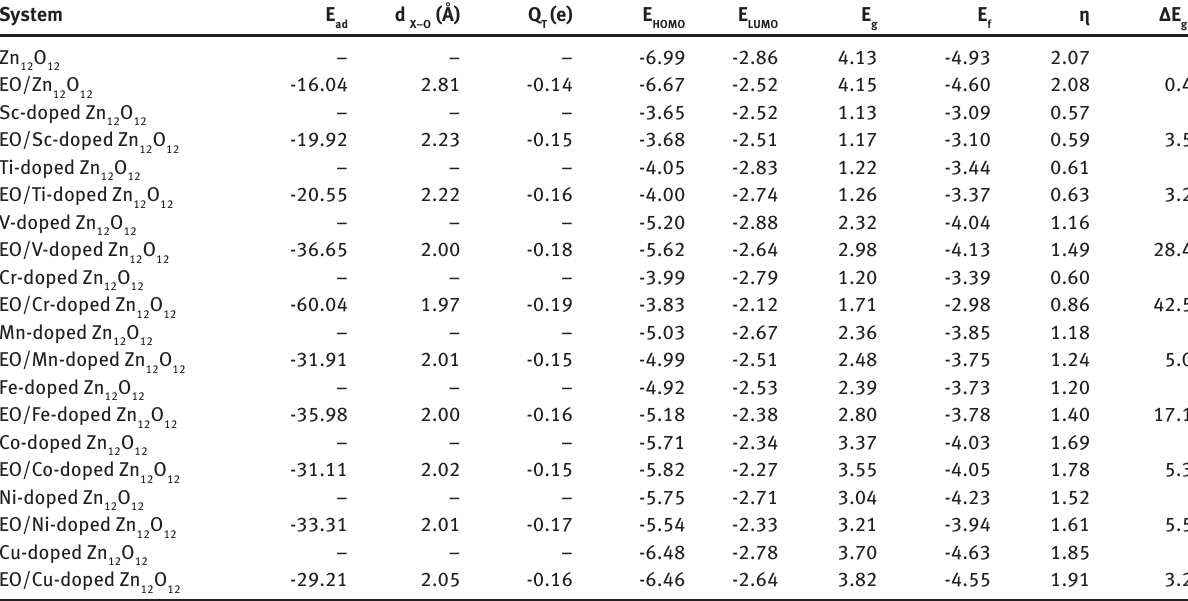
(kcal/mol), HOMO, LUMO, E and E (eV) for the studied systems. The average total Mulliken charge transfer from ad f g ). The nearest atom-to-atom distance between the O atom of EO, X (X = Zn, Sc, Ti, V, Cr, Mn, Fe, Co, Ni, and T O (Å) and their E change (ΔE ) values after the EO adsorption. 12 12 g g